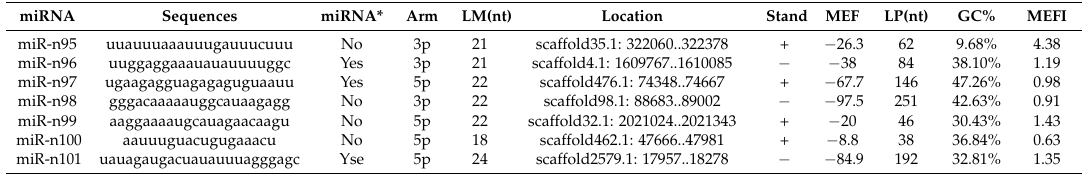
Table 3. Novel miRNA especially detected in stems and roots of P. euphratica (not detected in leaves). miRNA